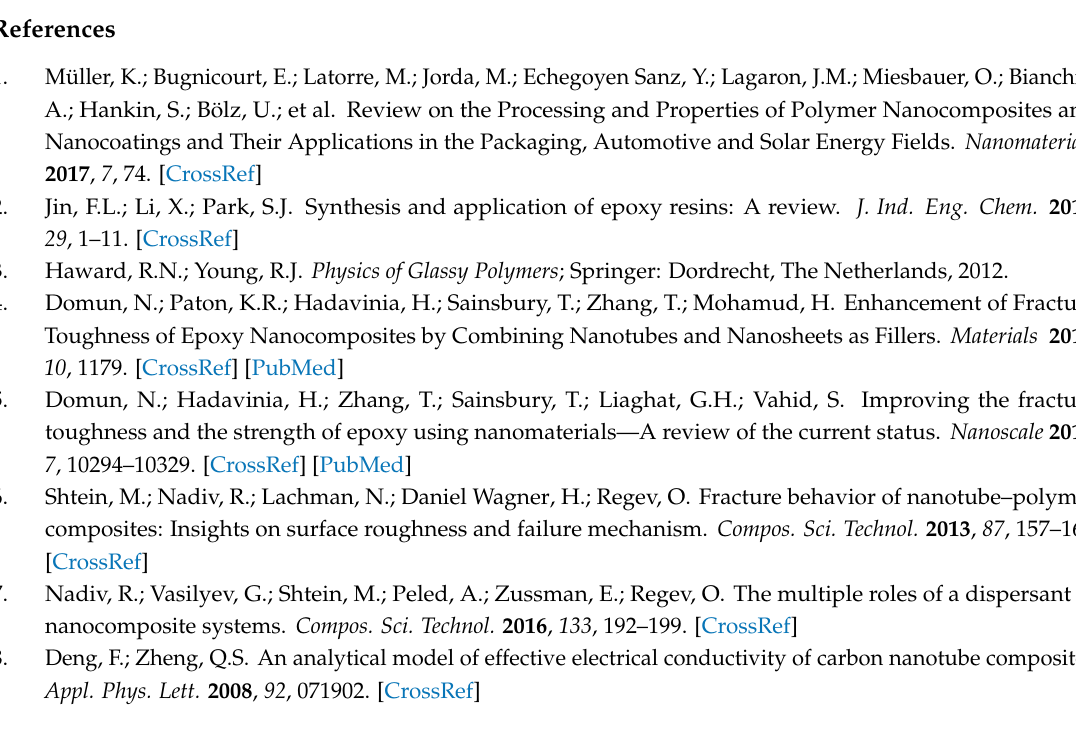
Figure A20. TEM images for Tuball purified at ( a ) low magnification and ( b ) high